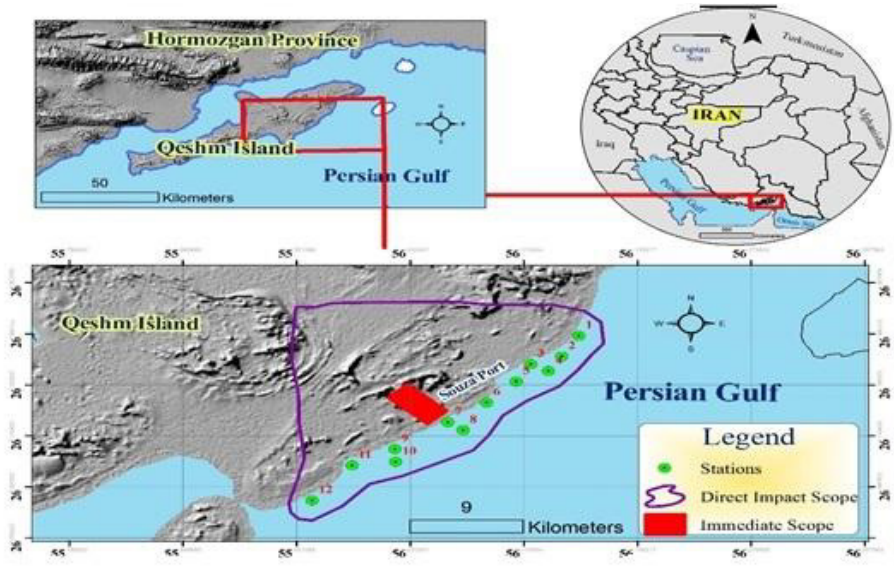
Fig. 1: The study area and water sampling stations